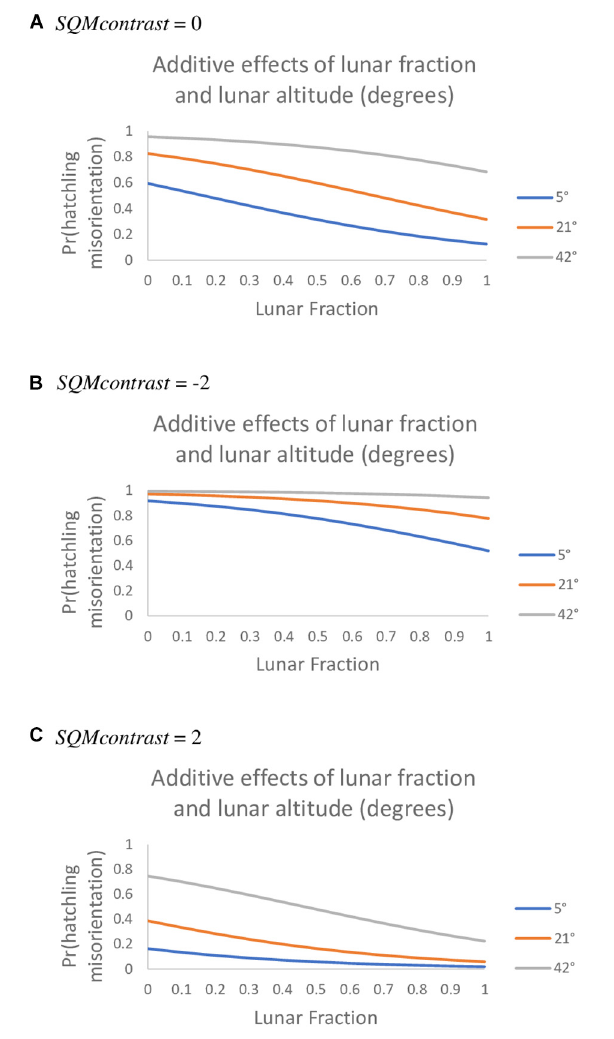
FIGURE 2 | The probability loggerhead ( Caretta caretta ) hatchlings were misoriented under an additive model with the predictor variables lunar fraction , lunar altitude , and SQMcontrast values of 0 (A) , − 2 (B) , and 2 (C) (80 ◦ AOA, 10 ◦ SQM data, observed range was − 5.0 to